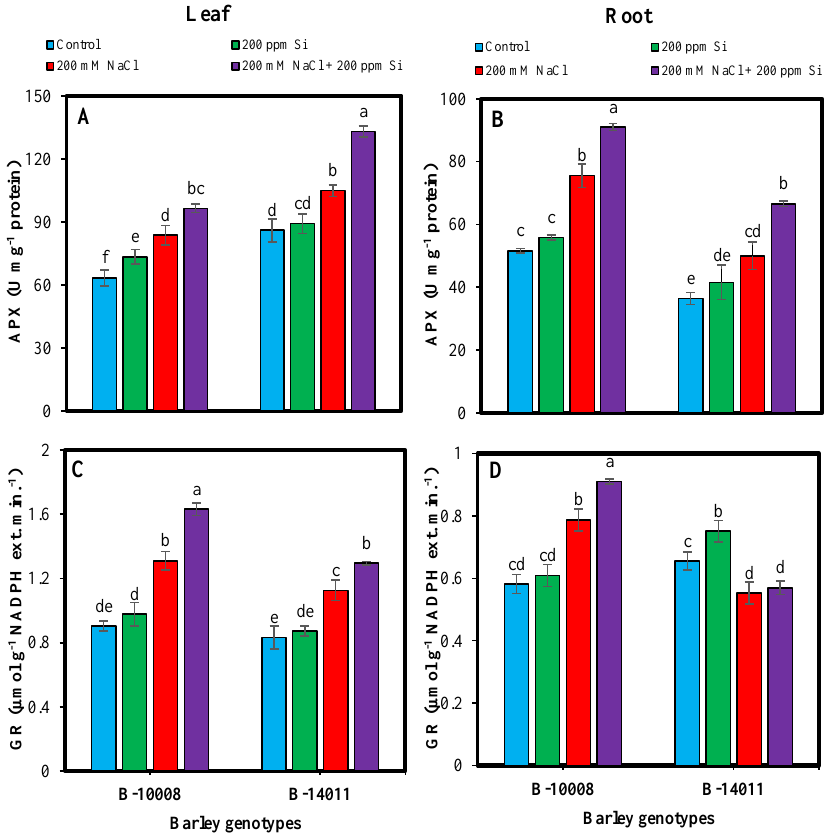
Figure 2. Ascorbate peroxidase (APX) ( A , B ) (Umg − 1 protein) and glutathione reductase (GR) ( C , D ) (µmol g −1 NADPH ext. min −1 ) contents in leaf and root of barley genotypes modulated by application of silicon through rooting media under salinity stress. The values represented by bars are means of four replicates ± SE. Different small letters (a–e) on bars denote significant difference at p ≤ 0.05 (Duncan’s multiple range test). Values sharing same letter within each subfigure are non-significant statistically.